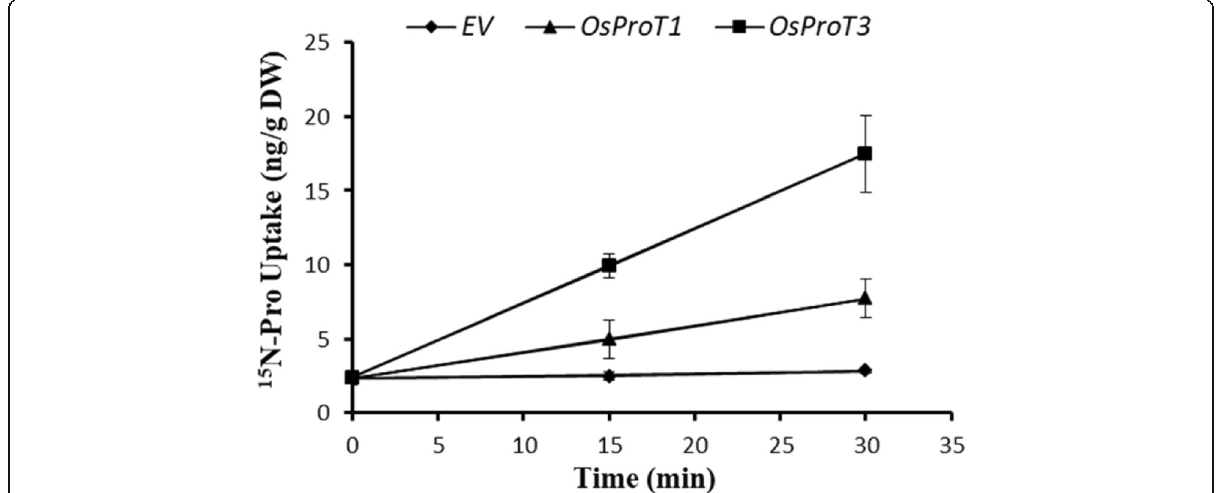
Fig. 4 Uptake of 15 N-labeled Pro by yeast 22 △ 10 α cells. Yeast cells expressing OsProT1 or OsProT3 were incubated with 1.5 mM 15 N-Pro for 15 min and 30 min, and the 15 N retained in the cells was subsequently measured. Values are means ± SD, n = 4